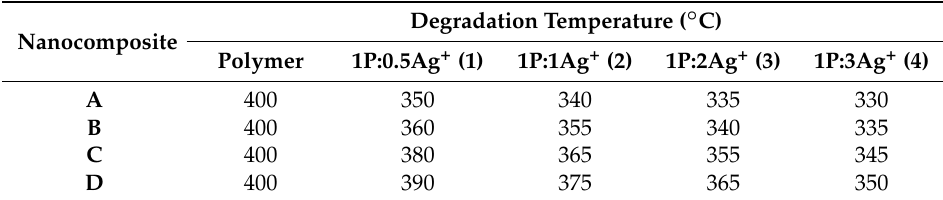
Figure 8. TGA curves of the polymer A and the nanocomposites. Table 4. Degradation temperatures of the samples. Table 4. Degradation temperatures of the samples.